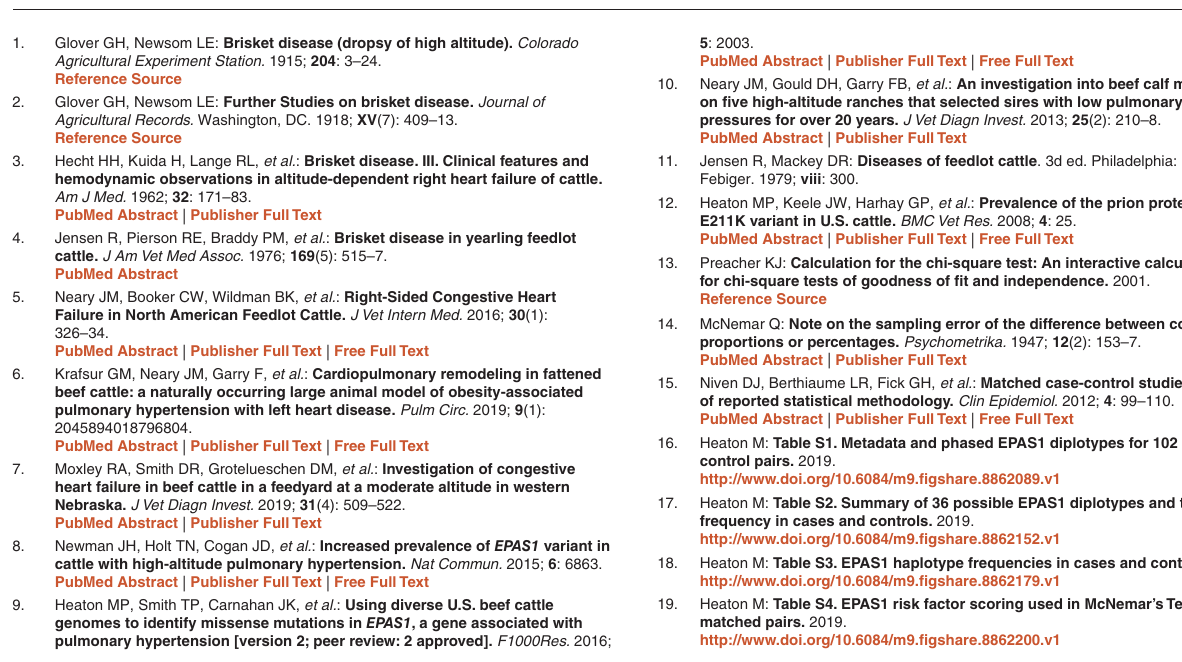
Figshare: Table S2. Summary of 36 possible EPAS1 diplotypes and their frequency in cases and controls. https://doi.org/10.6084/ m9.figshare.8862152.v1 17 Figshare: Table S3. EPAS1 haplotype frequencies in cases and controls. https://doi.org/10.6084/m9.figshare.8862179.v1 18 Figshare: Table S4. EPAS1 risk factor scoring used in McNemar’s Test with 102 matched pairs. https://doi.org/10.6084/ m9.figshare.8862200.v1